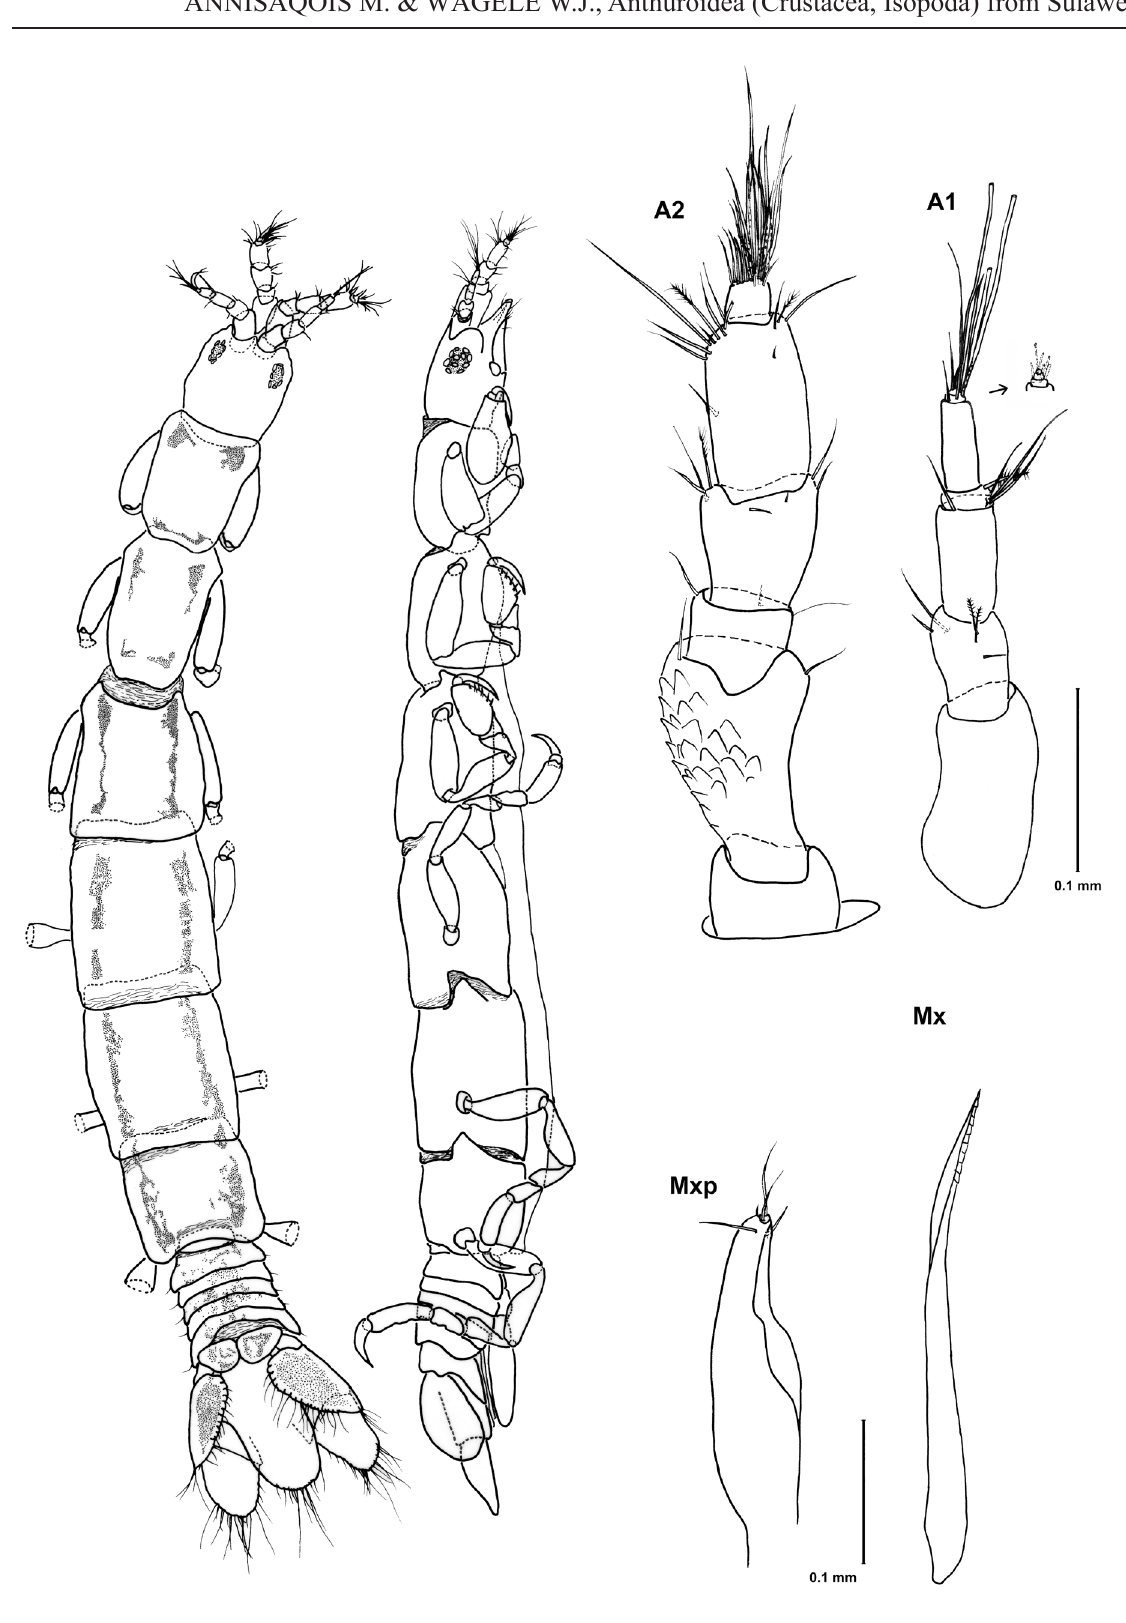
Fig. 32. Colanthura gerungi sp. nov., ♀, allotype in dorsal and ventrolateral view (3.9 mm) (MZB Iso 110). Abbreviations: A1 = antenna 1; A2 = antenna 2; Mx = maxilla; Mxp =